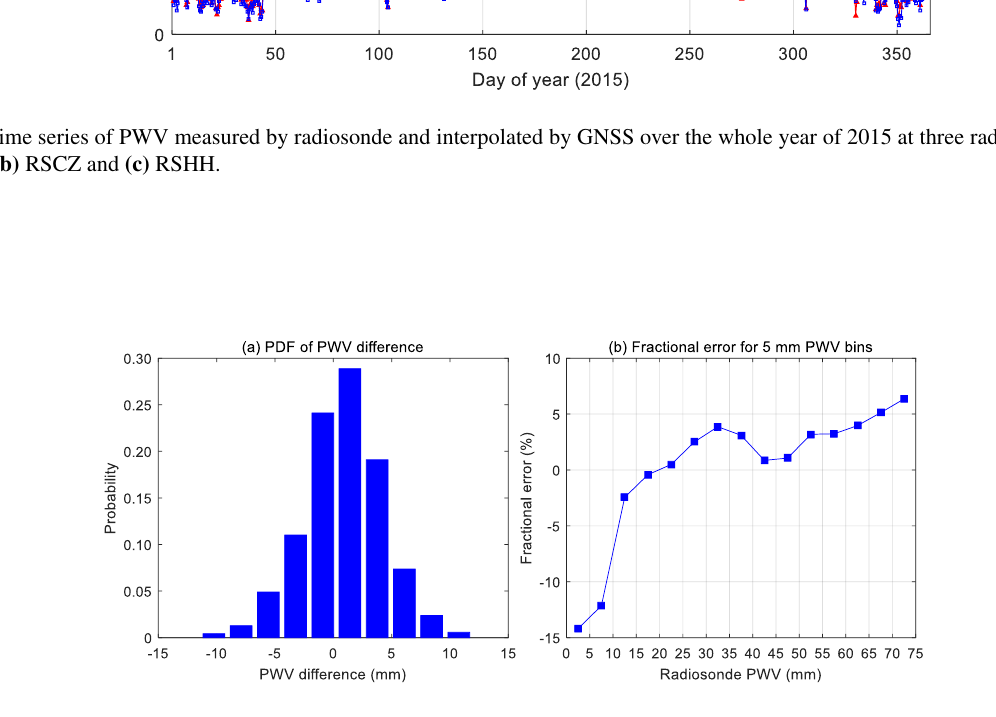
Figure 5. (a) PDF of PWV difference and (b) fractional error as percent by radiosonde 5mm PWV bins. All the three radiosonde stations are used in the